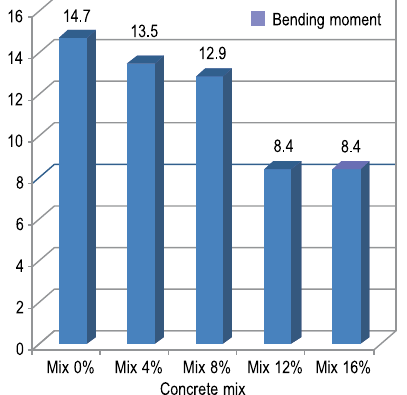
Fig. 6. Bending moment of beam samples